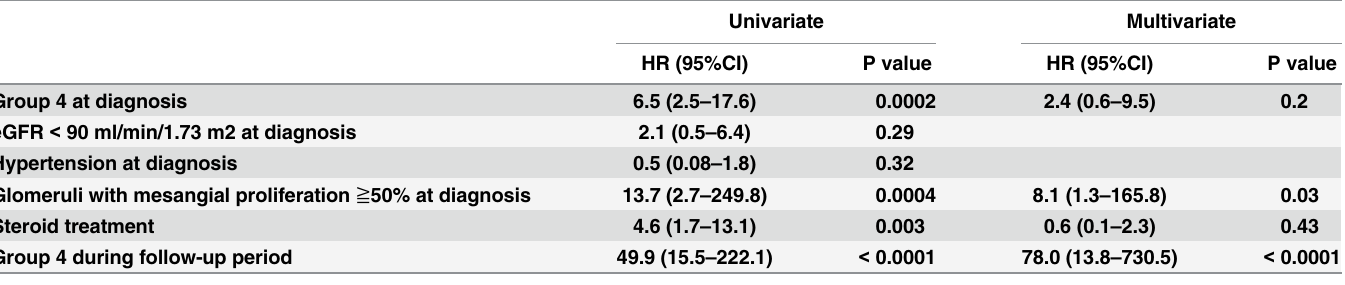
Table 3. Predicted risk factors for chronic renal